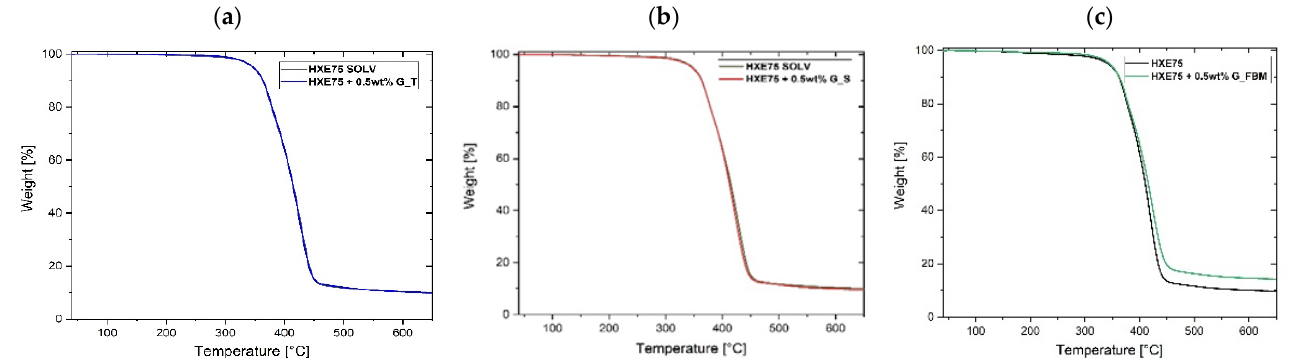
Figure 3. TGA of the neat epoxy matrix and the GNP based nanocomposites. ( a ) HXE75+0.5 wt%_G_T. ( b ) HXE75 + 0.5 wt%_G_S. ( c ) HXE75 + 0.5 wt%_G_FBM.